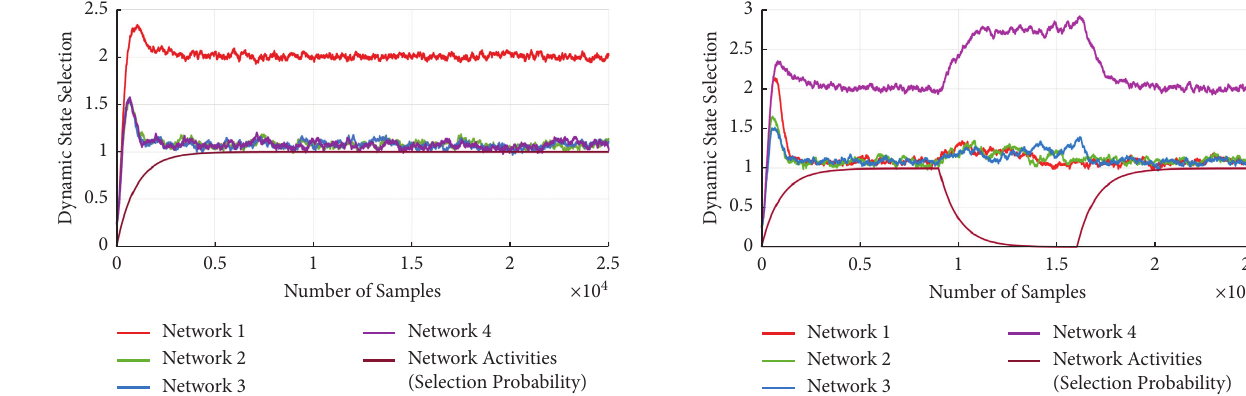
Figure 4: Effect of threshold on network connectivity for � 3 ) . sensitivity � 5 ( V thrl